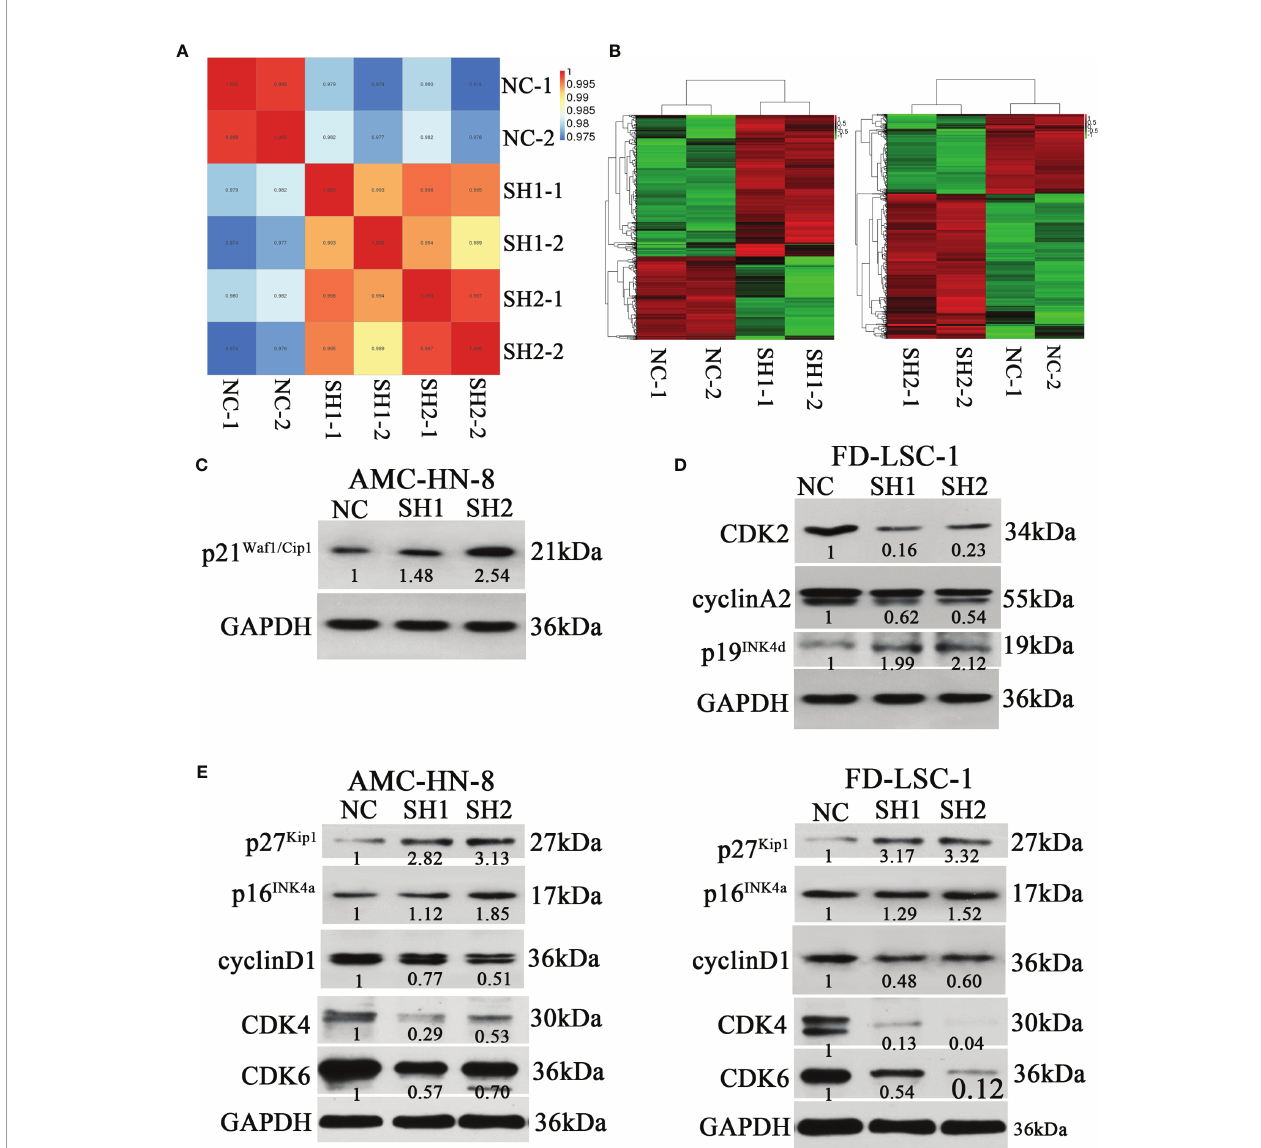
FIGURE 5 | Differences of the expression of cell cycle-related proteins between DIAPH1 knockdown (SH) cells and the negative control (NC) cells. (A) Intersample correlation test of AMC-HN-8 cells by RNA-sequencing analysis on the Illumina sequencing platform. (B) Results of cluster analysis of differentially expressed genes in AMC-HN-8 cells. (C – E) Western blot analysis of the expression of cell cycle-related proteins in AMC-HN-8 and FD-LSC-1 cells. Numbers labeled under the bands were the relative expression and the relative expression of NC cells was set as